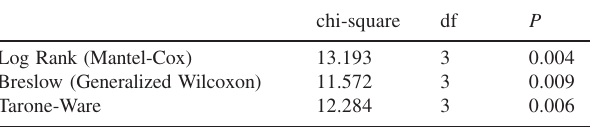
Table 8 . Statistical analysis for the different types of surgery, as specified in Table 7.